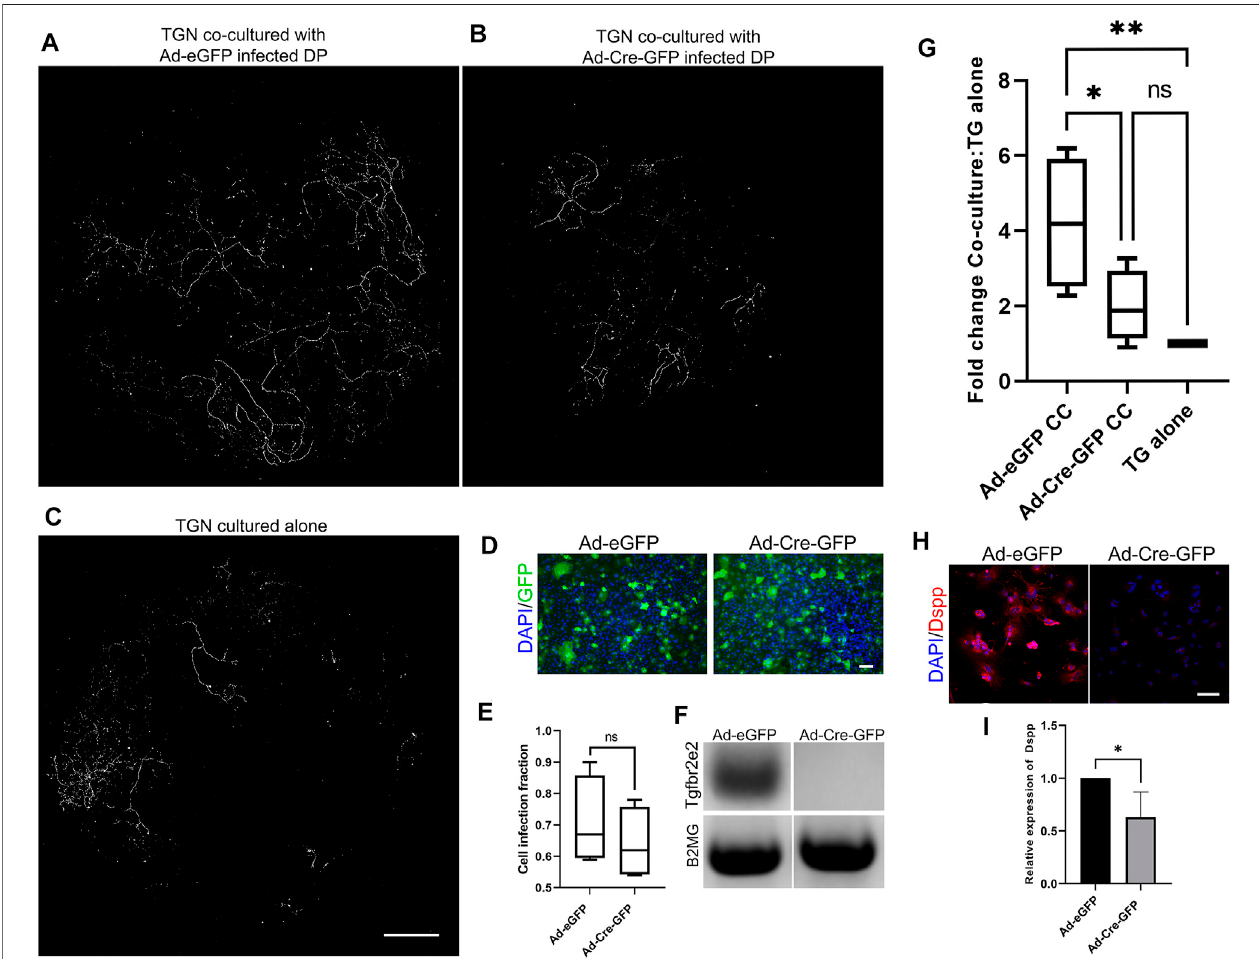
FIGURE6| Tgfbr2 signalinginprimaryDPmediatestrigeminalneuriteoutgrowthinco-culture. (A – C) Thy1-YFPtrigeminalneuronswereculturedinTranswell fi lters with3 μ mporesatopprimary Tgfbr2 f/f DPCs.Immuno fl uorescencewasperformedfortheYFPproteinusingananti-GFPantibodyforhighlyspeci fi cstainingofneuronal structures over the entire fi lter. Maximum projections of 100 μ m z-stack confocal microscopy images at 10× were collected and stitched with stitching software. TG neurons demonstrated signi fi cantly more outgrowth when co-cultured with DPCs (A) than when cultured alone (C) . Neurite outgrowth was not induced when neurons were co-cultured with DP infected with Ad-Cre-GFP to knock down Tgfbr2 (B) . The scale bar is 1,000 μ m for (A – C) . (D) Adenovirus infection was con fi rmed with GFP expression and normalized to DAPI to con fi rm equivalent numbers of infected cells between control Ad-GFP and Ad-Cre-GFP DPCs (D,E) The scale bar is 100 μ m for (D) . Semi-quantitative PCR con fi rmed Tgfbr2 KD (F) . Images of axonal outgrowth on the fi lters were auto-thresholded with FIJI software to remove background fl uorescence and the remaining pixels were quanti fi ed and normalized tothe TGN cultured alone from each experimental set (G) . * p < 0.05, ** p < 0.01 by2- way ANOVA tests with a Tukey ’ s multiple comparison post-hoc set. (H) Representative images of DPCs from co-culture demonstrating reduced expression of an odontoblast marker, DSPP. (I) Quanti fi cation of DSPP normalized to DAPI demonstrates a signi fi cant reduction in cells with Tgfbr2 deletion. * p < 0.05 by two-tailed unpaired t -test. All analyses are based on four separate